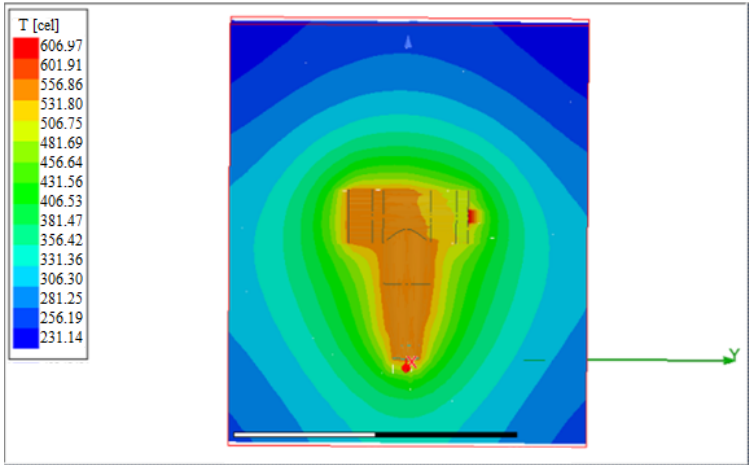
Figure 10. Temperature flow in the connector head, I m = 2